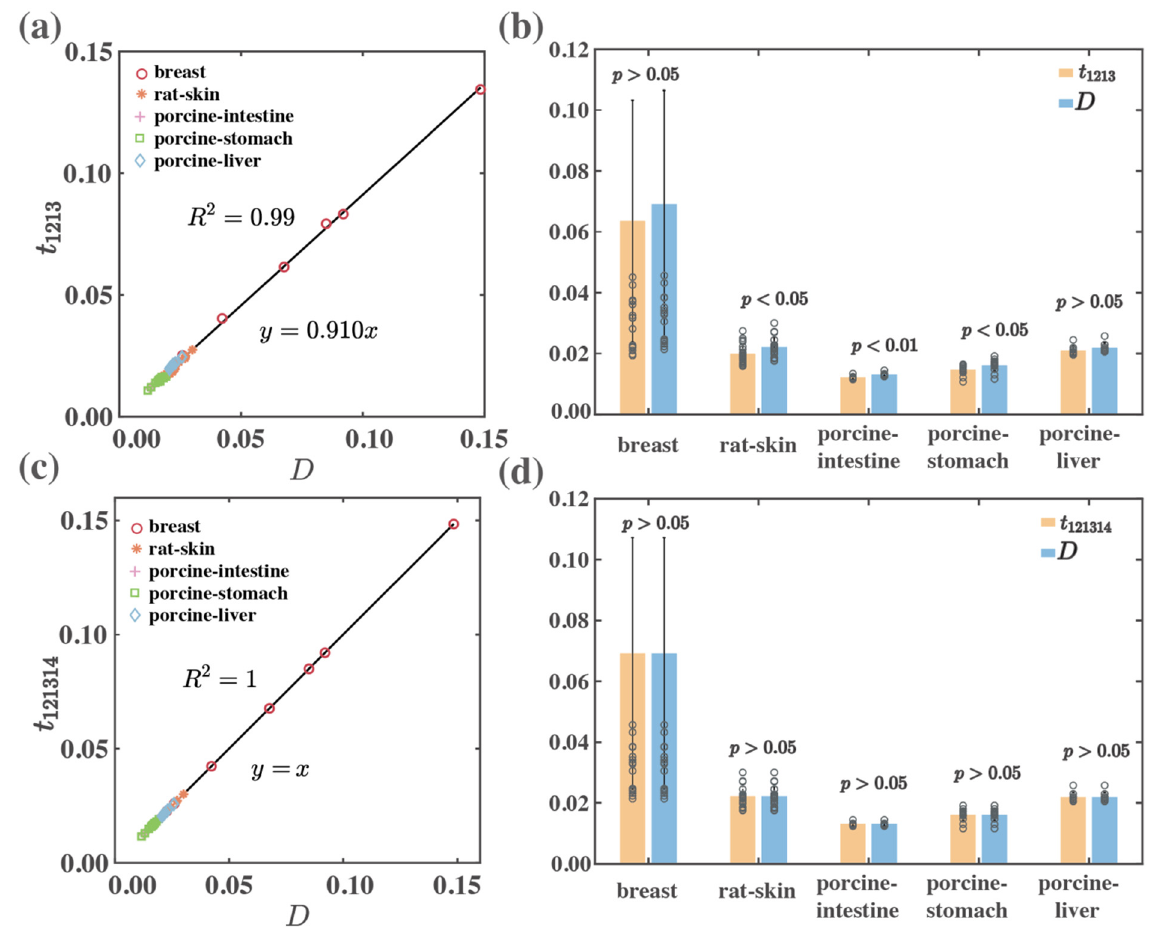
Figure 2. Comparison of backward measured MMT and MMPD diattenuation parameters of bulk tissue samples. ( a ) MMPD parameter D plotted against its counterpart MMT parameter t 1213 for correlation analysis with all five kinds of bulk tissue samples. ( b ) Statistical analysis bar chart of MMPD parameter D and MMT parameter t 1213 for each kind of bulk tissue samples. ( c ) MMPD parameter D plotted against its counterpart modified MMT parameter t 121314 for correlation analysis with all five kinds of bulk tissue samples. ( d ) Statistical analysis bar chart of MMPD parameter D and modified MMT parameter t 121314 for each kind of bulk tissue samples.